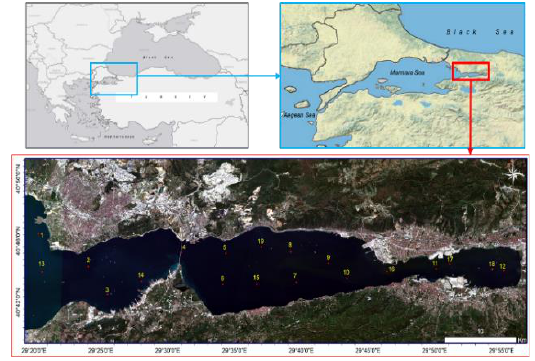
Figure 1. The map of Gulf of Izmit and location of 17 in-situ sampling points in Sentinel-2 satellite image (© Copernicus).